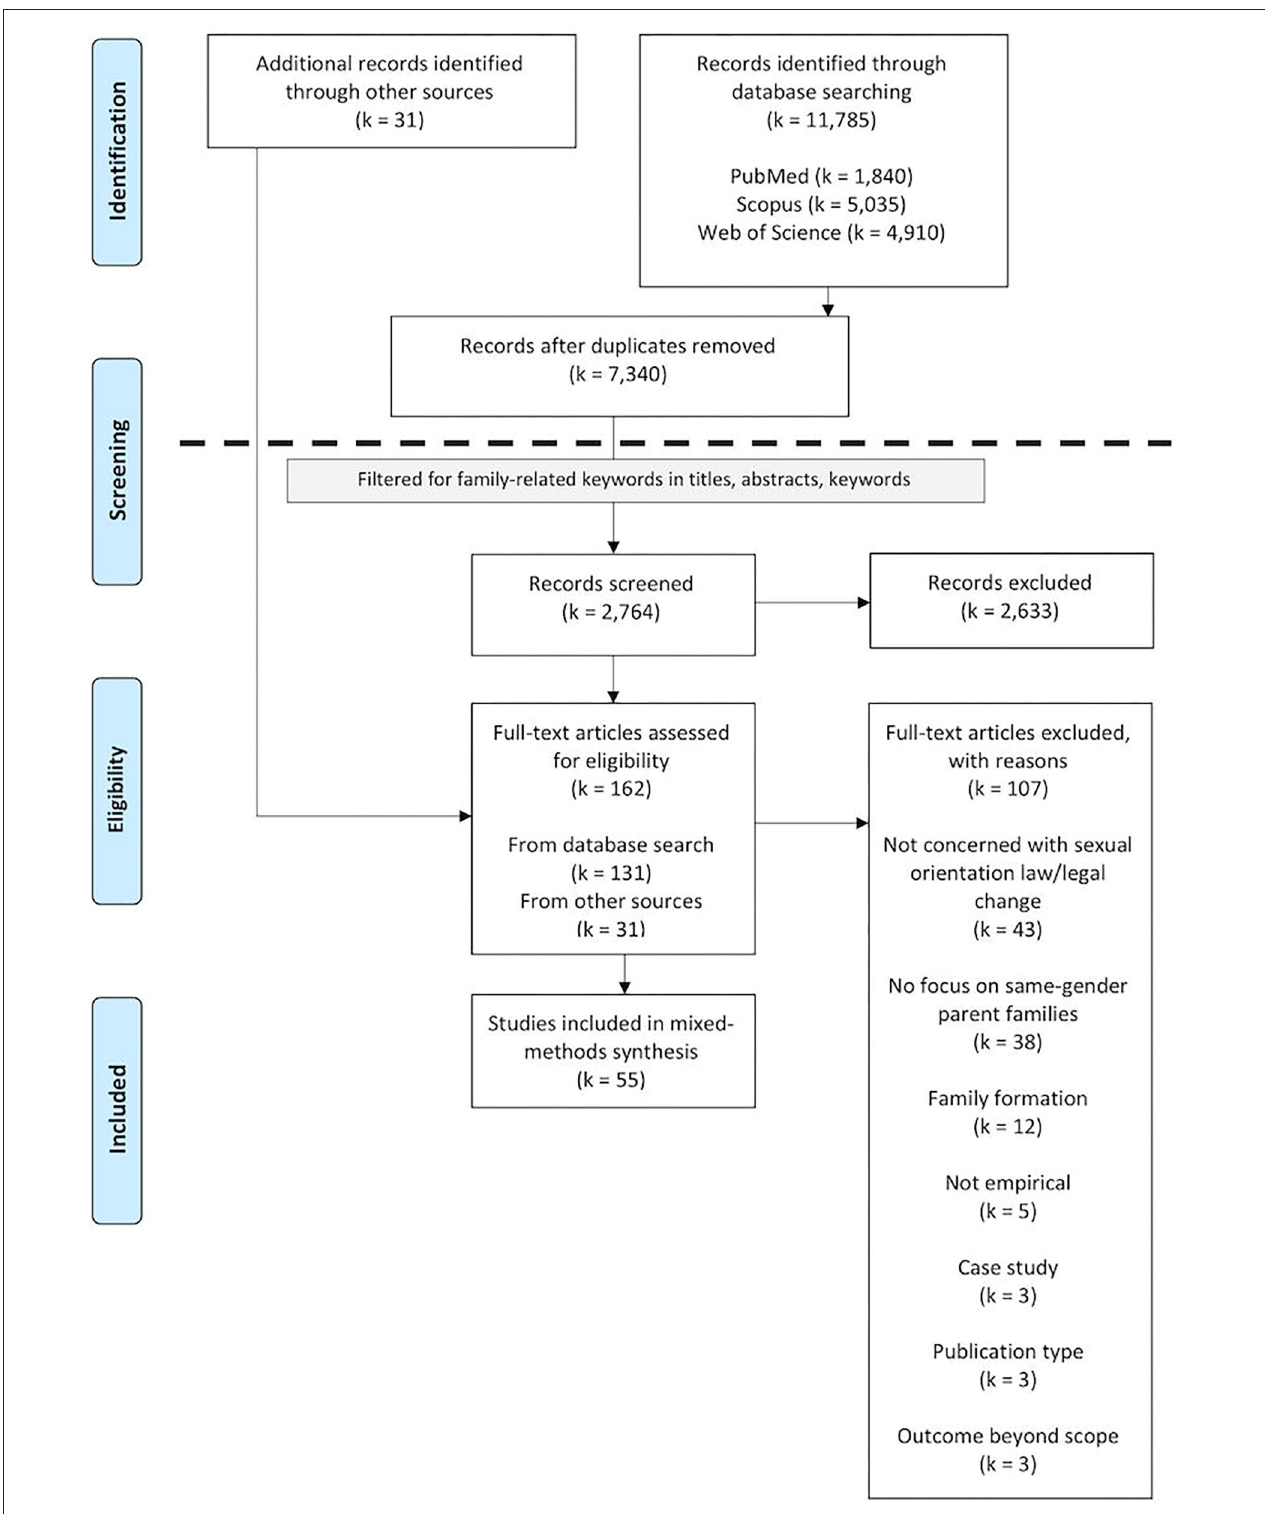
FIGURE 1 | PRISMA flow diagram of the study selection process.